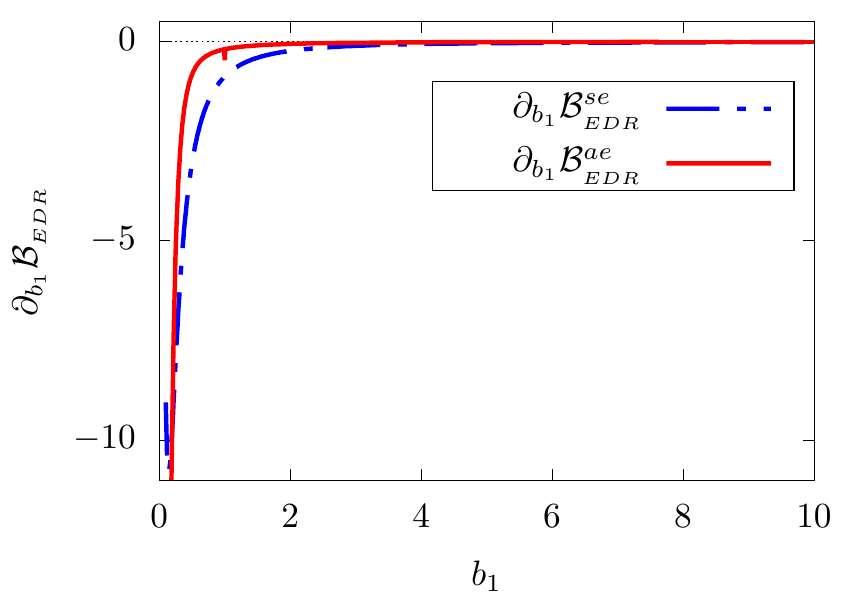
Figure 7 . The quantity ∂ b line. The quantity ∂ b